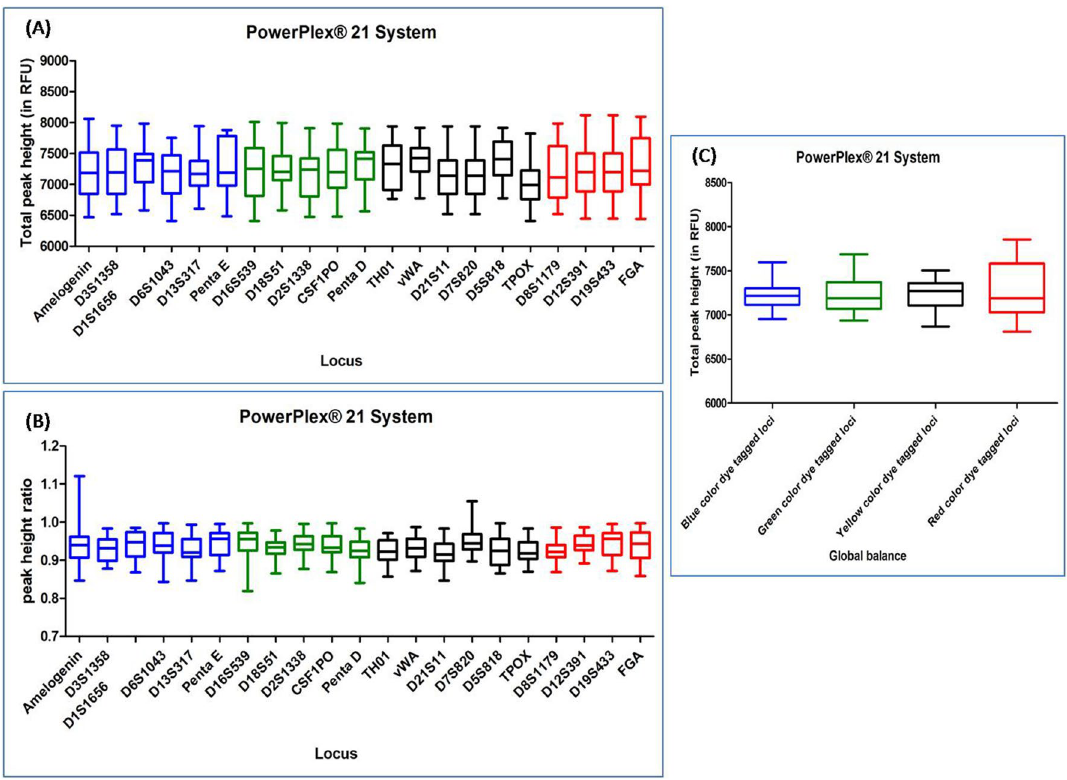
Figure 5. Quality assessment of DNA profile by Dunn’s multiple comparison test for the POWERPLEX 21 SYSTEM ( A ) Total peak height ( B ) Peak height ratio ( C ) Global